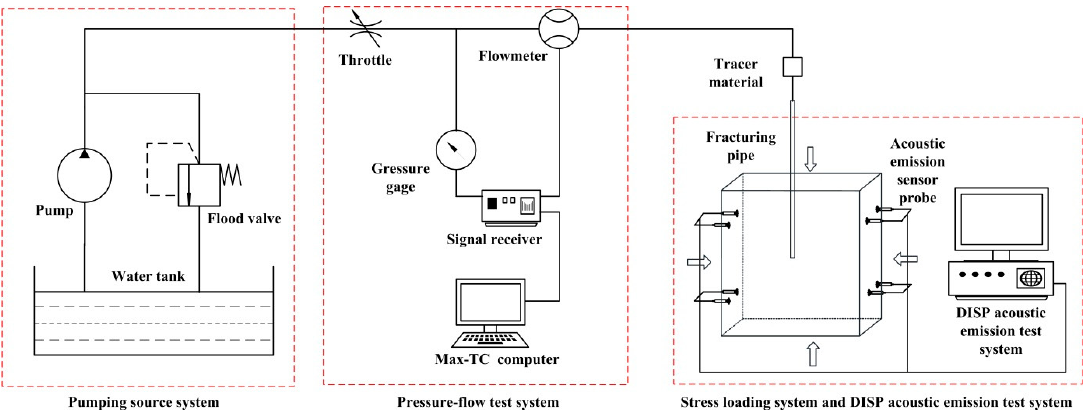
Figure 5. Schematic diagram showing the hydraulic fracturing (HF) test system.